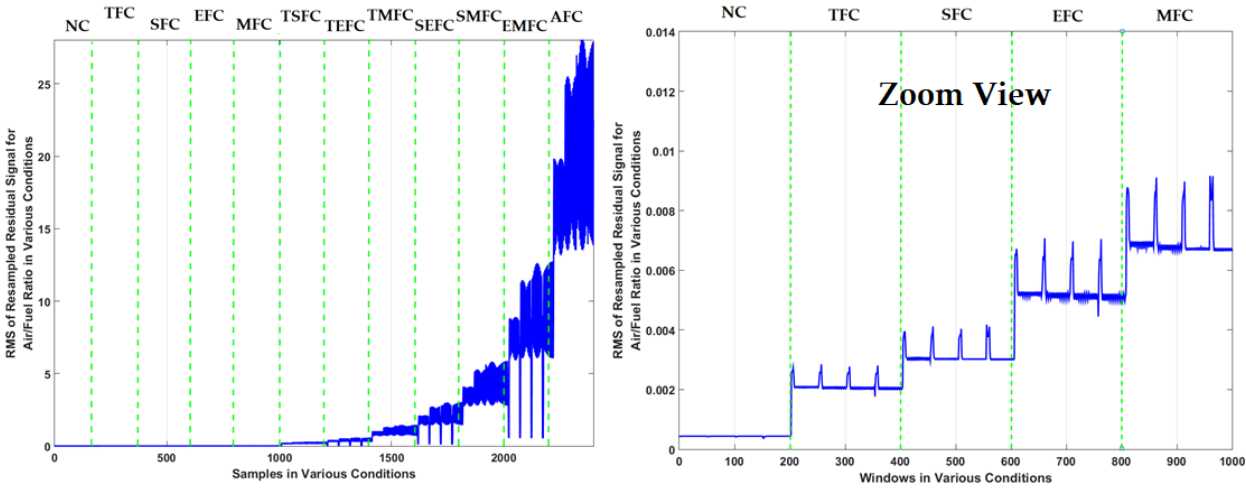
Figure 9. Resampled RMS residual signals for air-to-fuel ratio using the proposed FGAL-FLCR tech- nique.